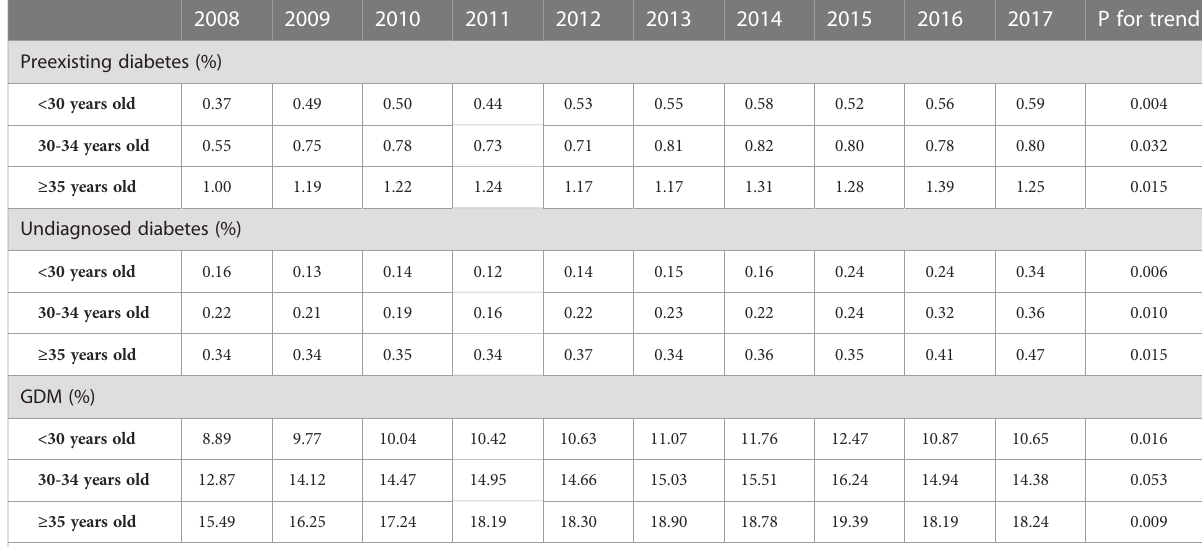
TABLE 3 Prevalence of preexisting diabetes mellitus, undiagnosed diabetes mellitus and gestational diabetes mellitus (GDM) in different age groups by year in Taiwan in 2008-2017*.